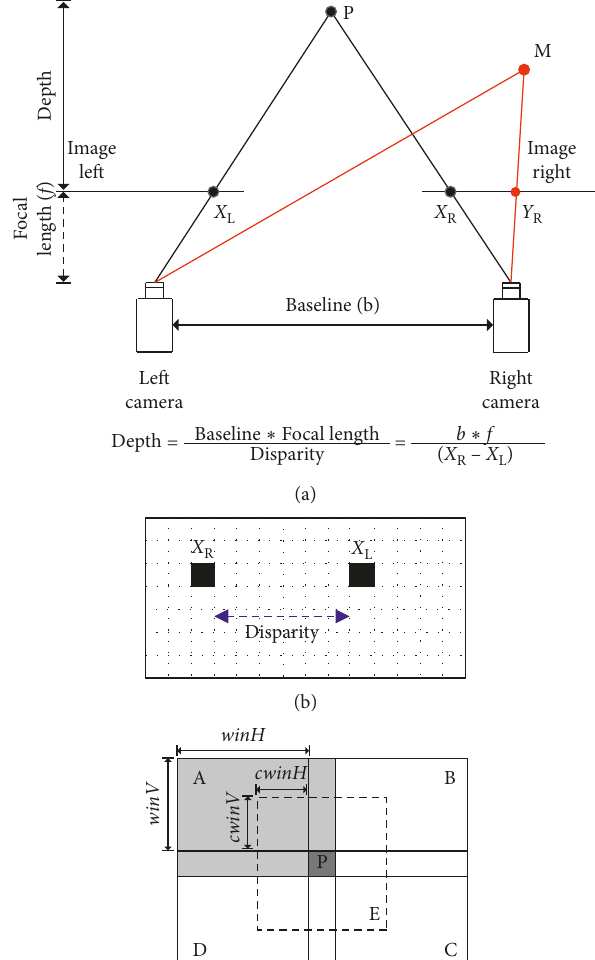
Figure 1: (a) Calculating the depth of an object in stereo matching problem. (b) Disparity is defined as the distance in pixels between ( X ) and ( X ). (c) 5-window SAD R L